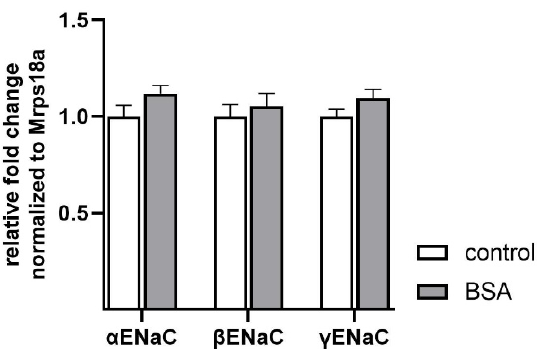
Figure 3. BSA does not affect ENaC mRNA expression. FDLE cells were cultured in MEM and stimulated with BSA (1.0 g/L) for 24 h. Data are displayed as mean + SEM normalized to control values (n = 8).